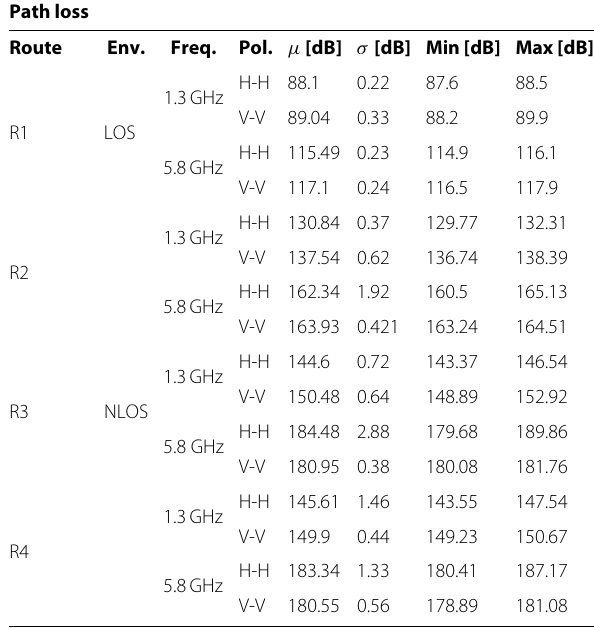
delay spread values for all routes and frequencies fit well with the normal distribution with μ mean and σ standard deviation parameters.